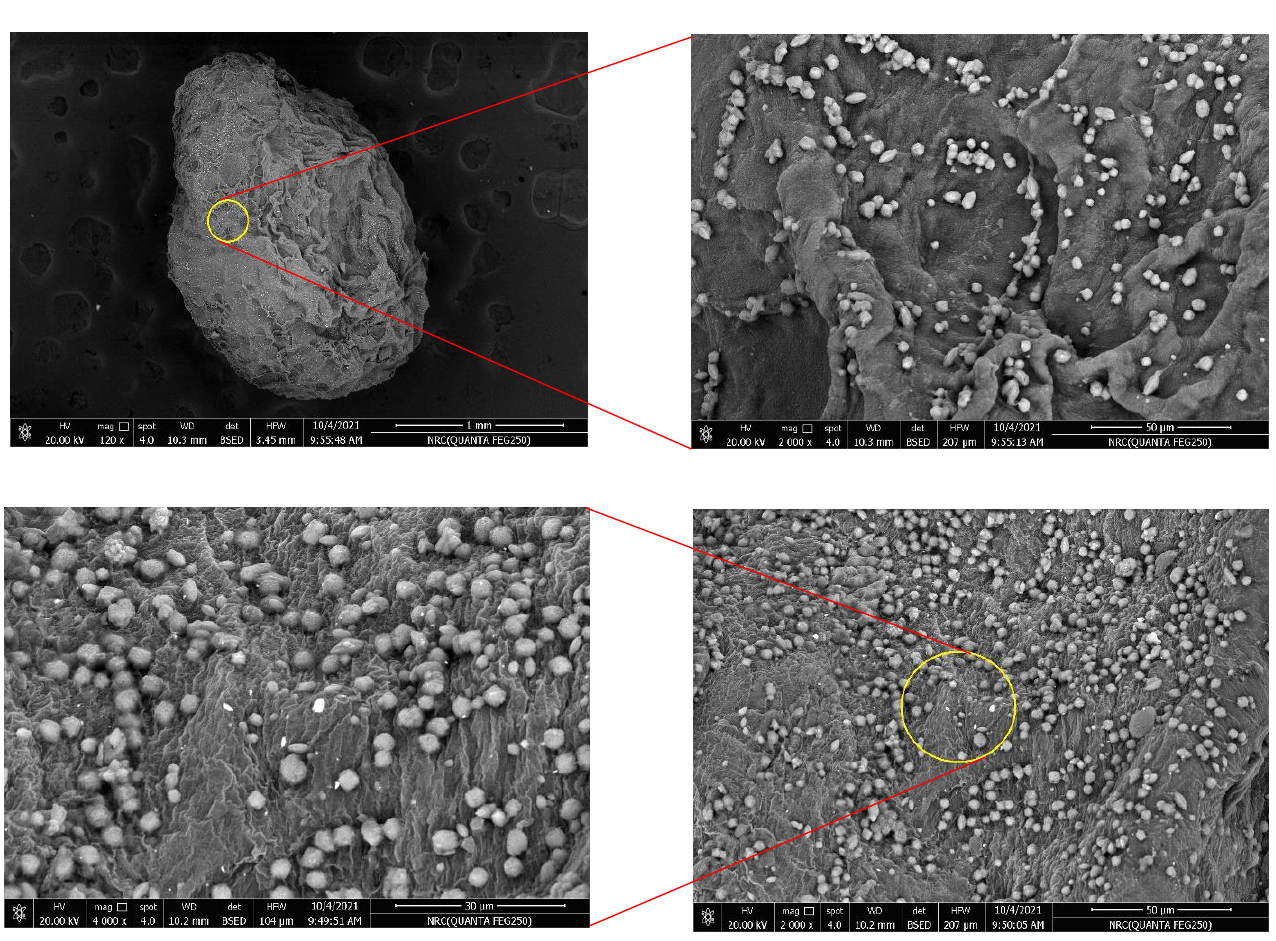
Figure 6. Thermal analysis TG and DrTGA for cellulose at 20 – 500 °C.